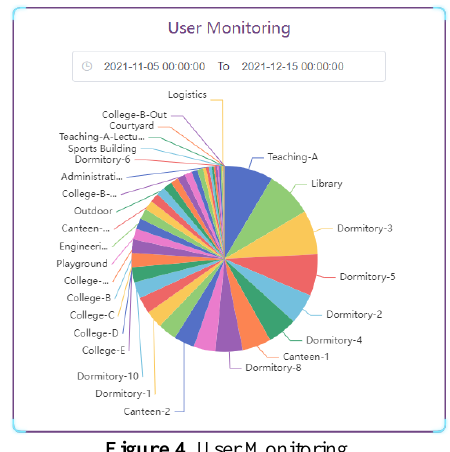
Figure 4 . User Monitoring.